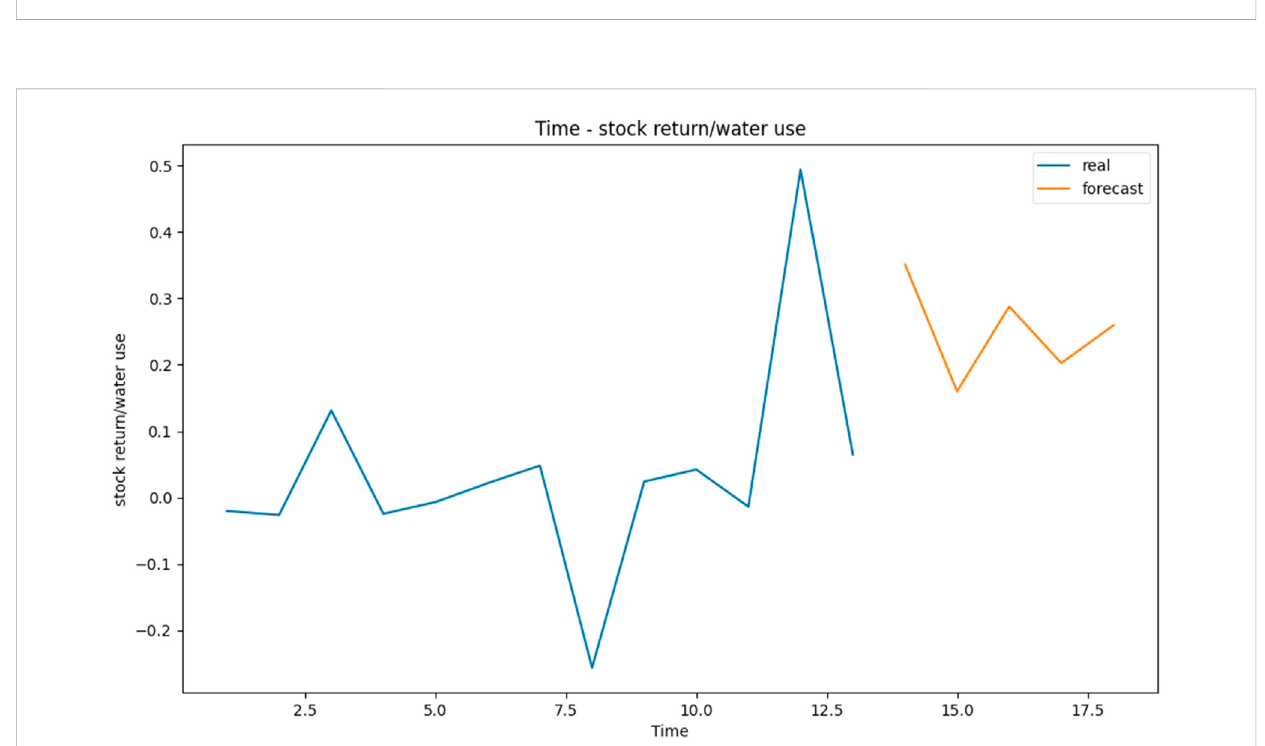
FIGURE 2 Forecast results in